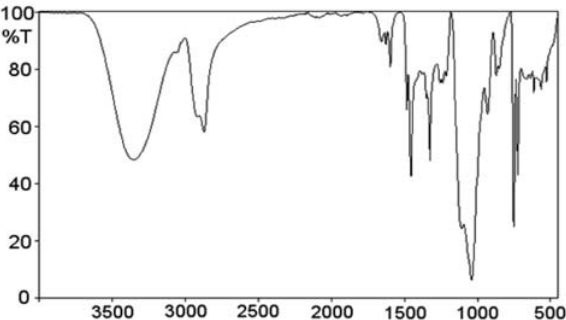
Fig. 2. IR spectrum of product of reaction obtained from the C : GL = 1 : 7 molar ratio